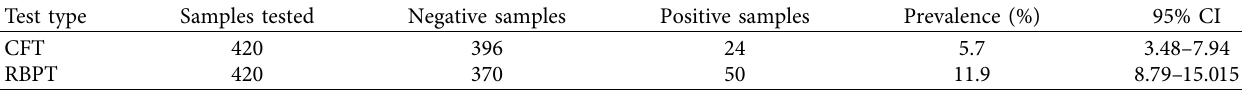
Table 2: Prevalence of bovine brucellosis by CFT and RBPT tests.